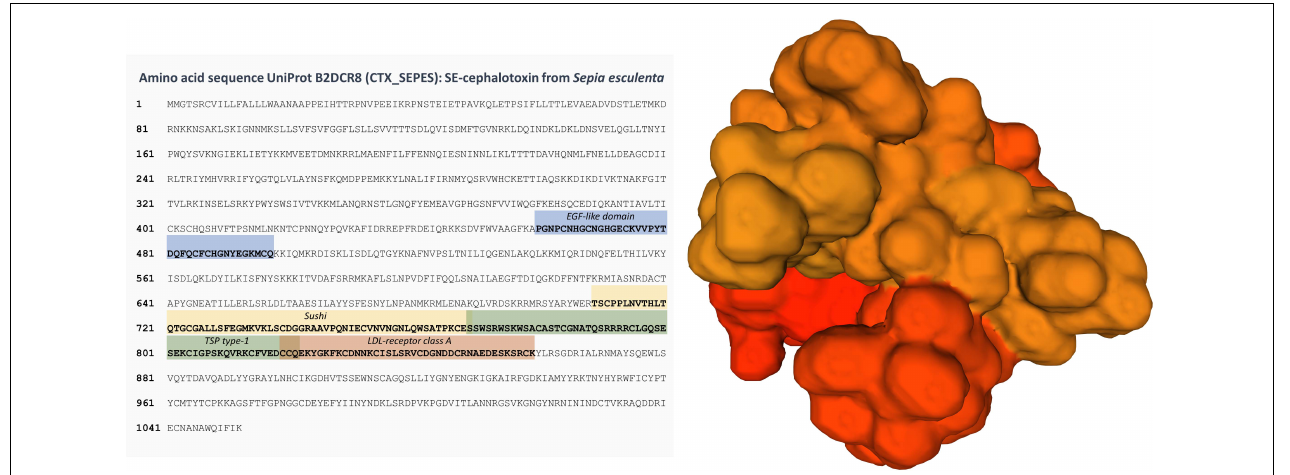
FIGURE 1 | Sequence and a predicted 3D model of SE-cephalotoxin. Conserved domains are highlighted in the sequence, namely EGF-like, Sushi, TSP type-1, and LDL-receptor class A. Molecule was produced with Swiss-Model from the UniProt record B2DCR8 (CTX_SEPES). Glycosylation is not represented. See Ueda et al. (2008) for further